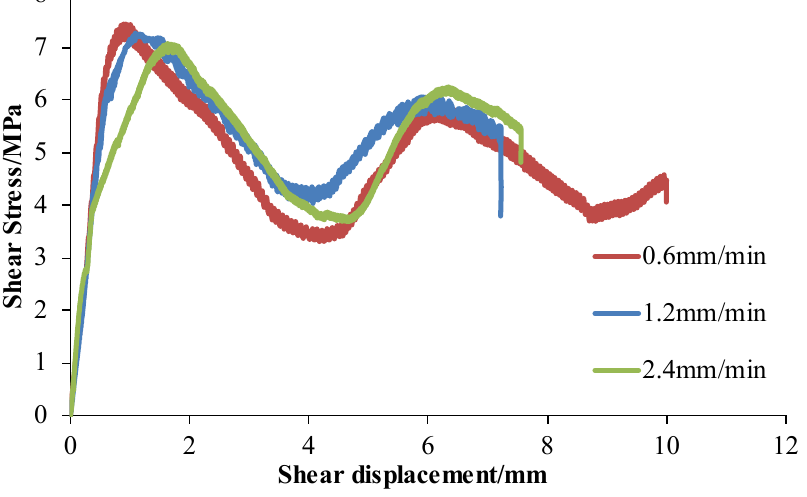
Figure 10. Shear stress–displacement curves under different shear rates at 4 MPa normal stress with a 10° undulating angle.